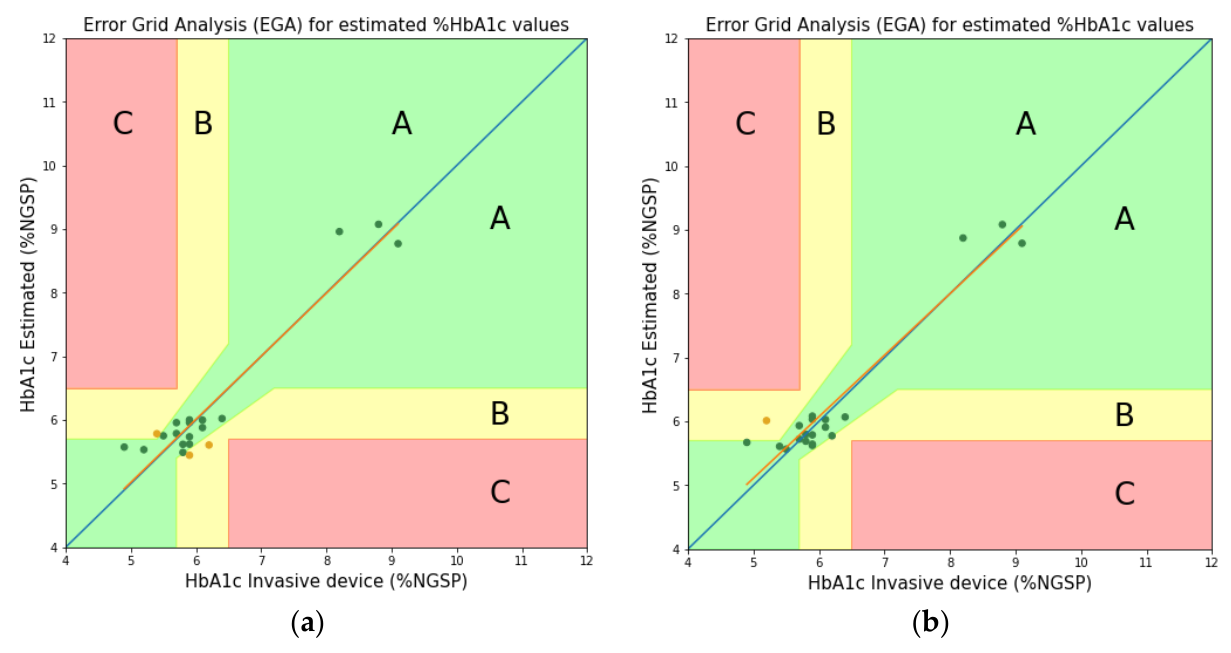
Figure 11. HbA1c Clarke’s error grid analysis (EGA) based on experimentally obtained molar absorption coefficients (Proposed). ( a ) Blood vessel model; ( b ) Whole finger model.